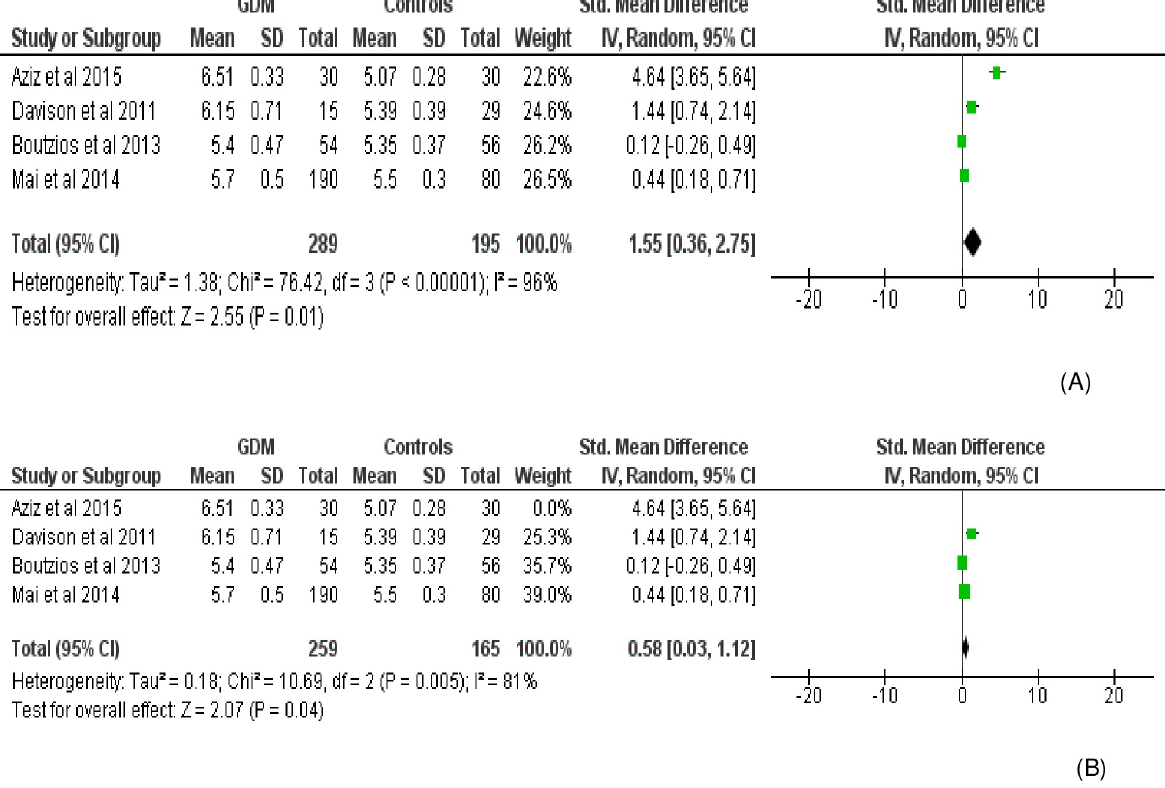
Fig 5. Forest plot depicting the level of HbA1c among women with GDM and controls. (A) without sensitivity analysis (B) with sensitivity analysis.